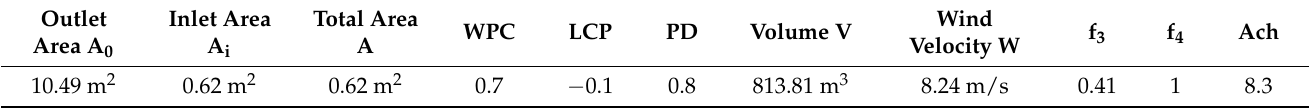
Table 1. Ventilation rate for 1 cm wide gaps.